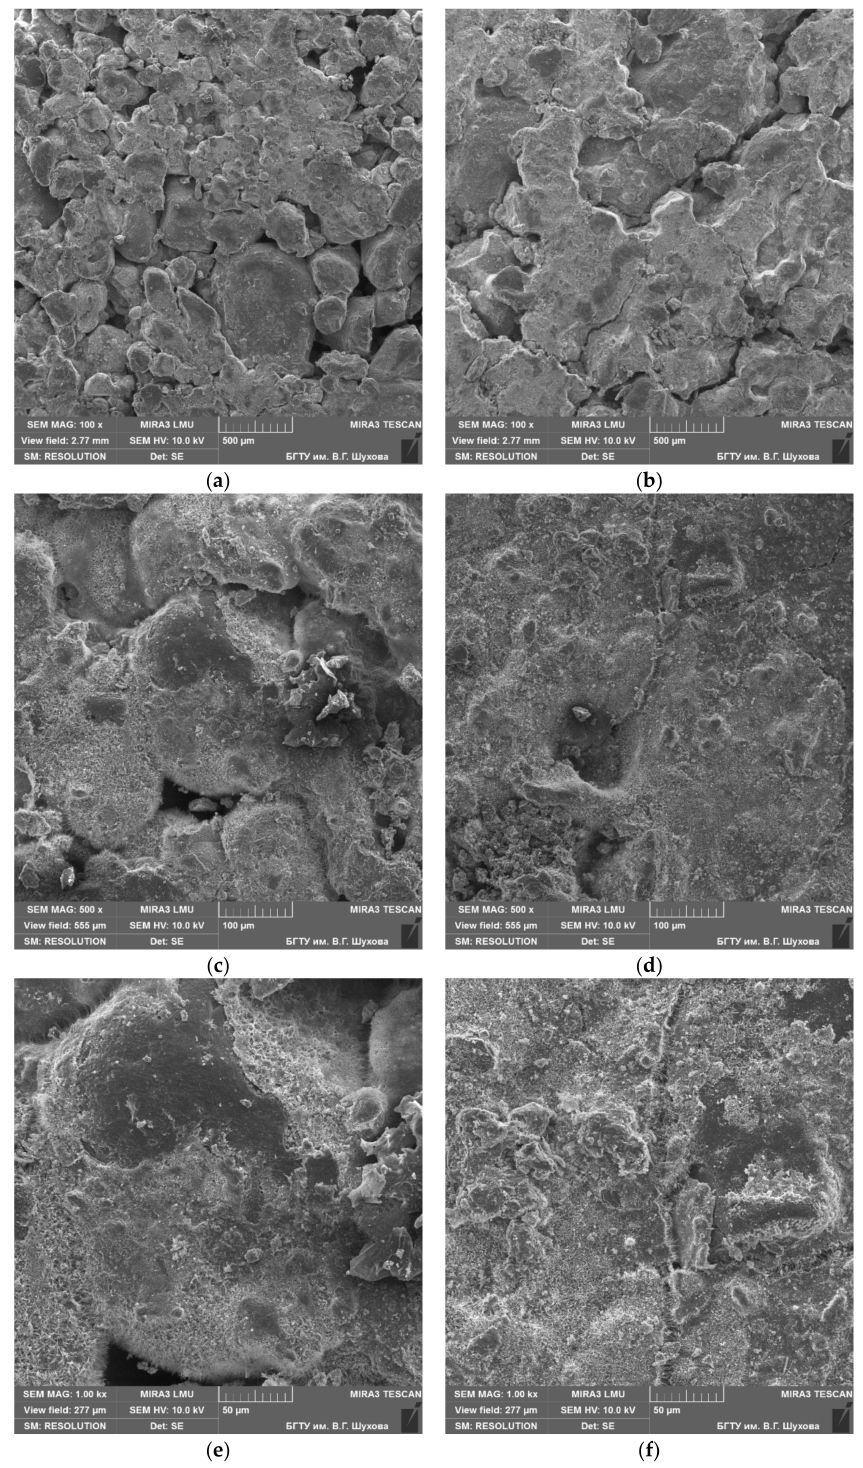
Figure 16. Surface microstructure of specimens depending on composition: ( a , c , e ) control; ( b , d , f ) ex- perimental with 15%